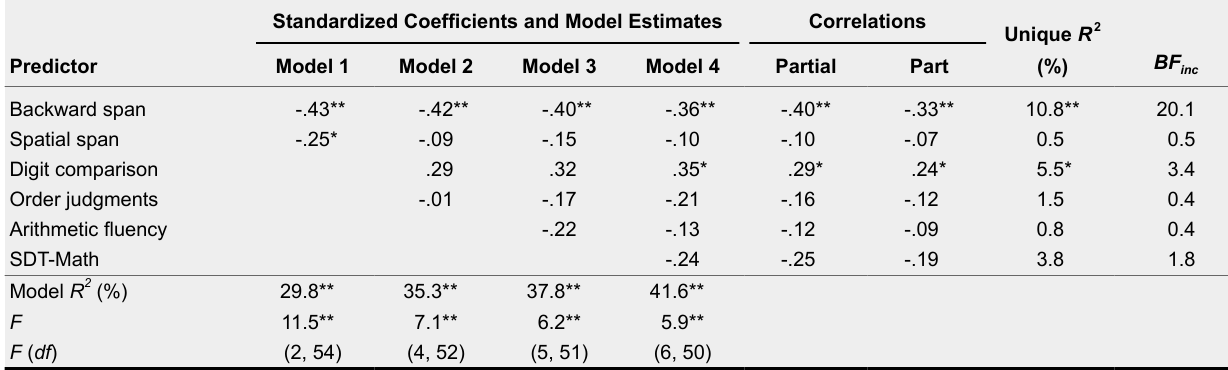
Regression Model for Number Line Accuracy (Percentage Absolute Error)